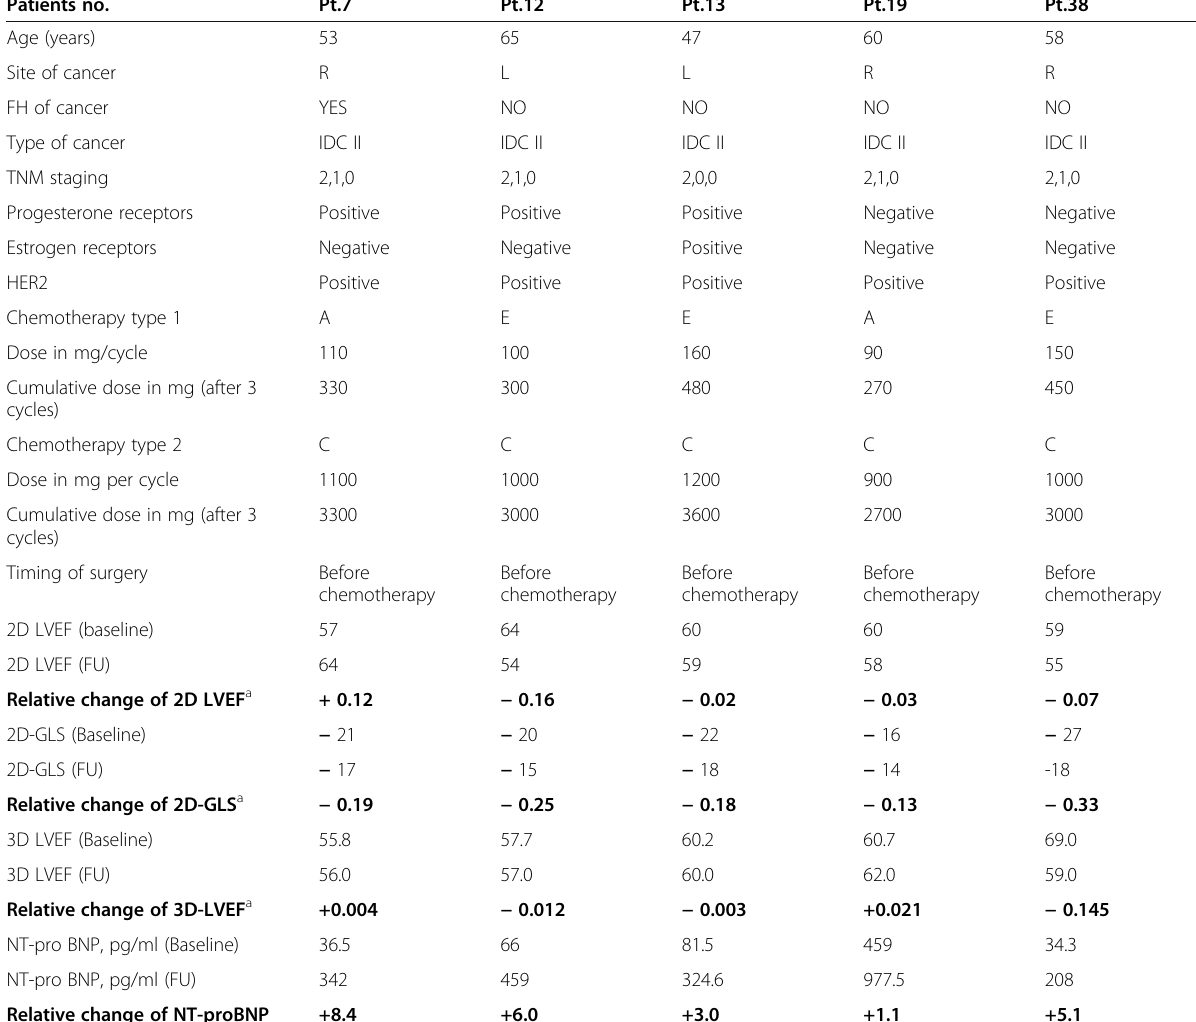
Table 6 Demographical, oncological, and echocardiographic data of patients who had an abnormally elevated level of plasma NT- pro BNP in the follow-up visit Patients